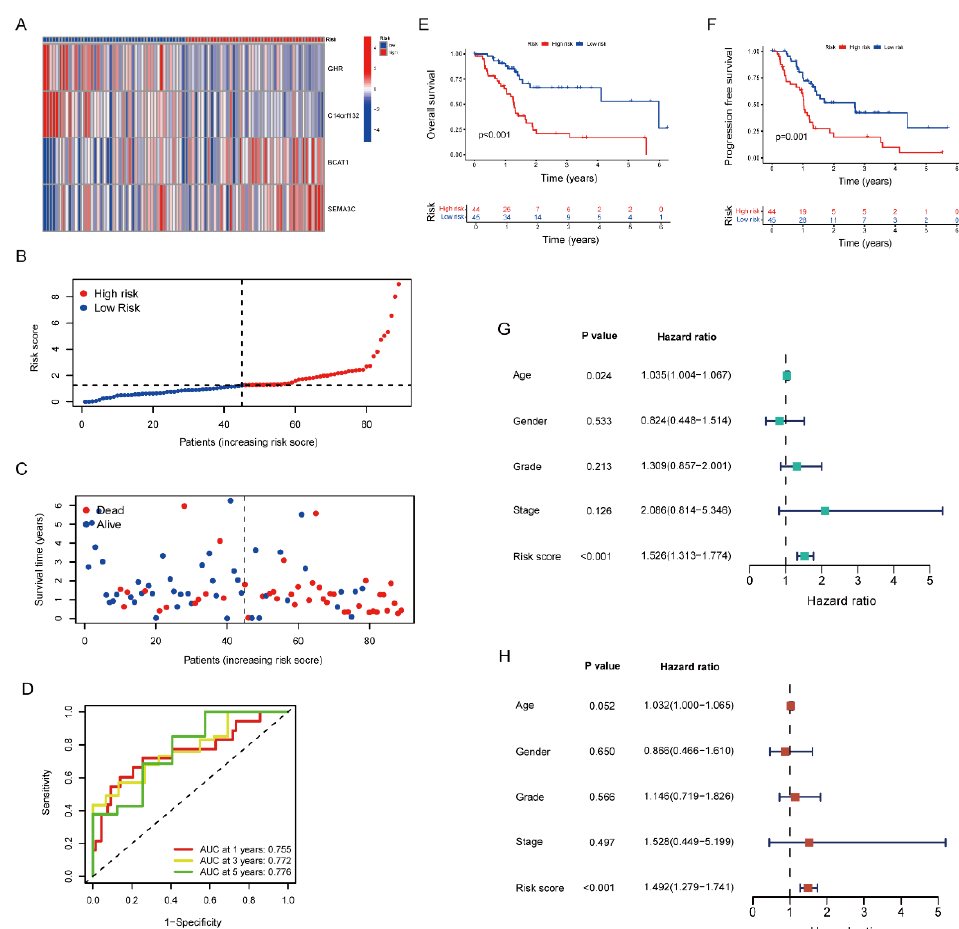
Figure 4. The Prognostic Value of Stroma- and Metastasis-Associated Risk Score Model in the Training Group. ( A ) The heat map illustrated the expression of four genes in each sample. ( B ) The distribution of low- and high-risk samples. ( C ) The correlation of risk score, survival status and survival time ( D ) ROC curve of the risk score. ( E , F ) Kaplan–Meier curve of overall survival and progression-free survival in low- and high-risk groups. ( G , H ) The univariate and multivariate Cox regression analysis of clinical characteristics and risk score.